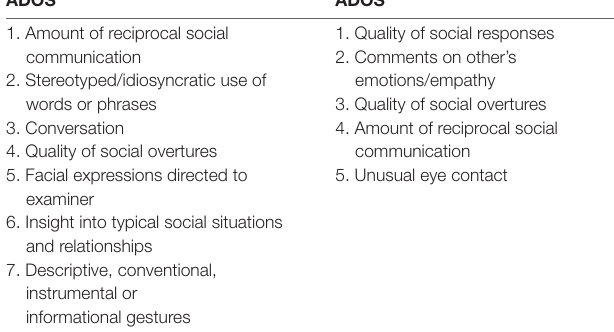
Adolescents/adults ADOS +